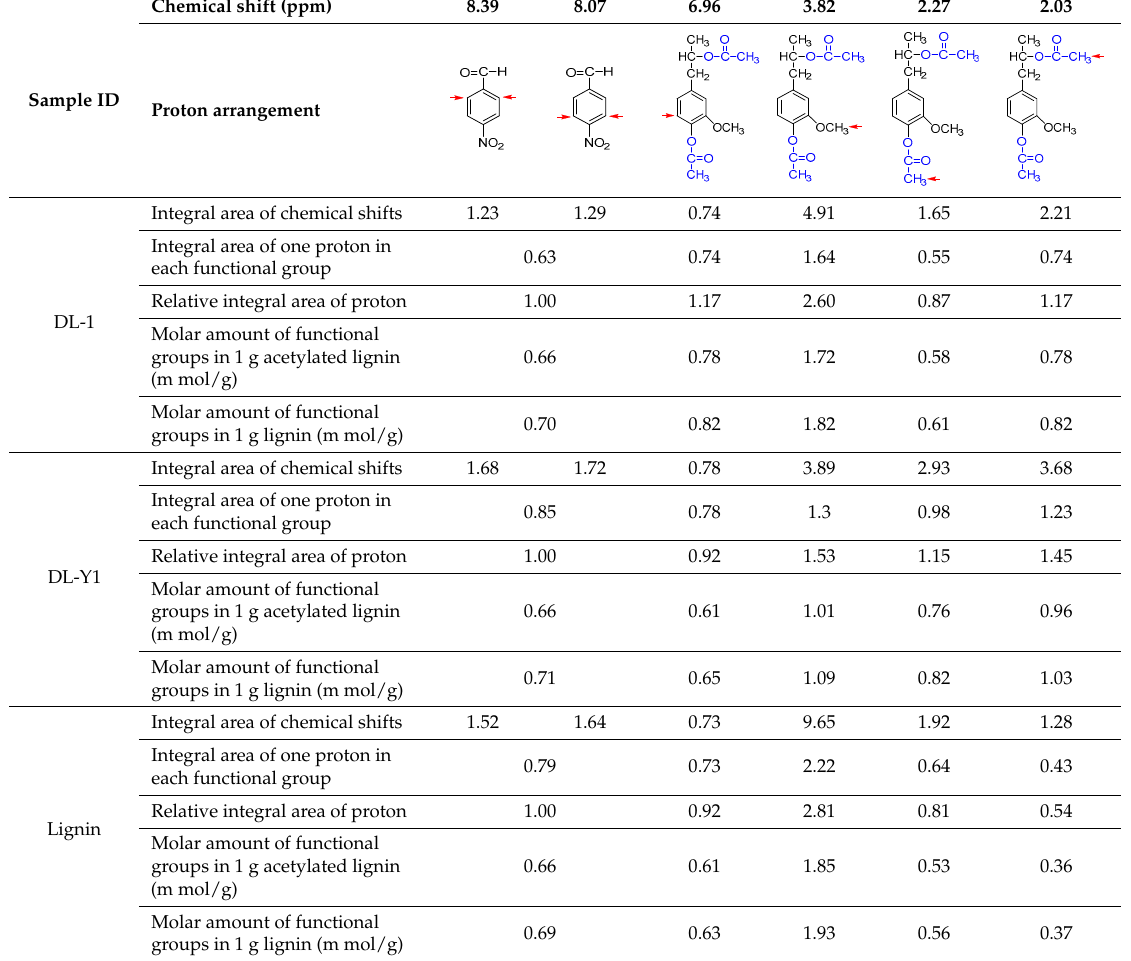
Table 3. The 1 H-NMR analysis of acetylated lignin.